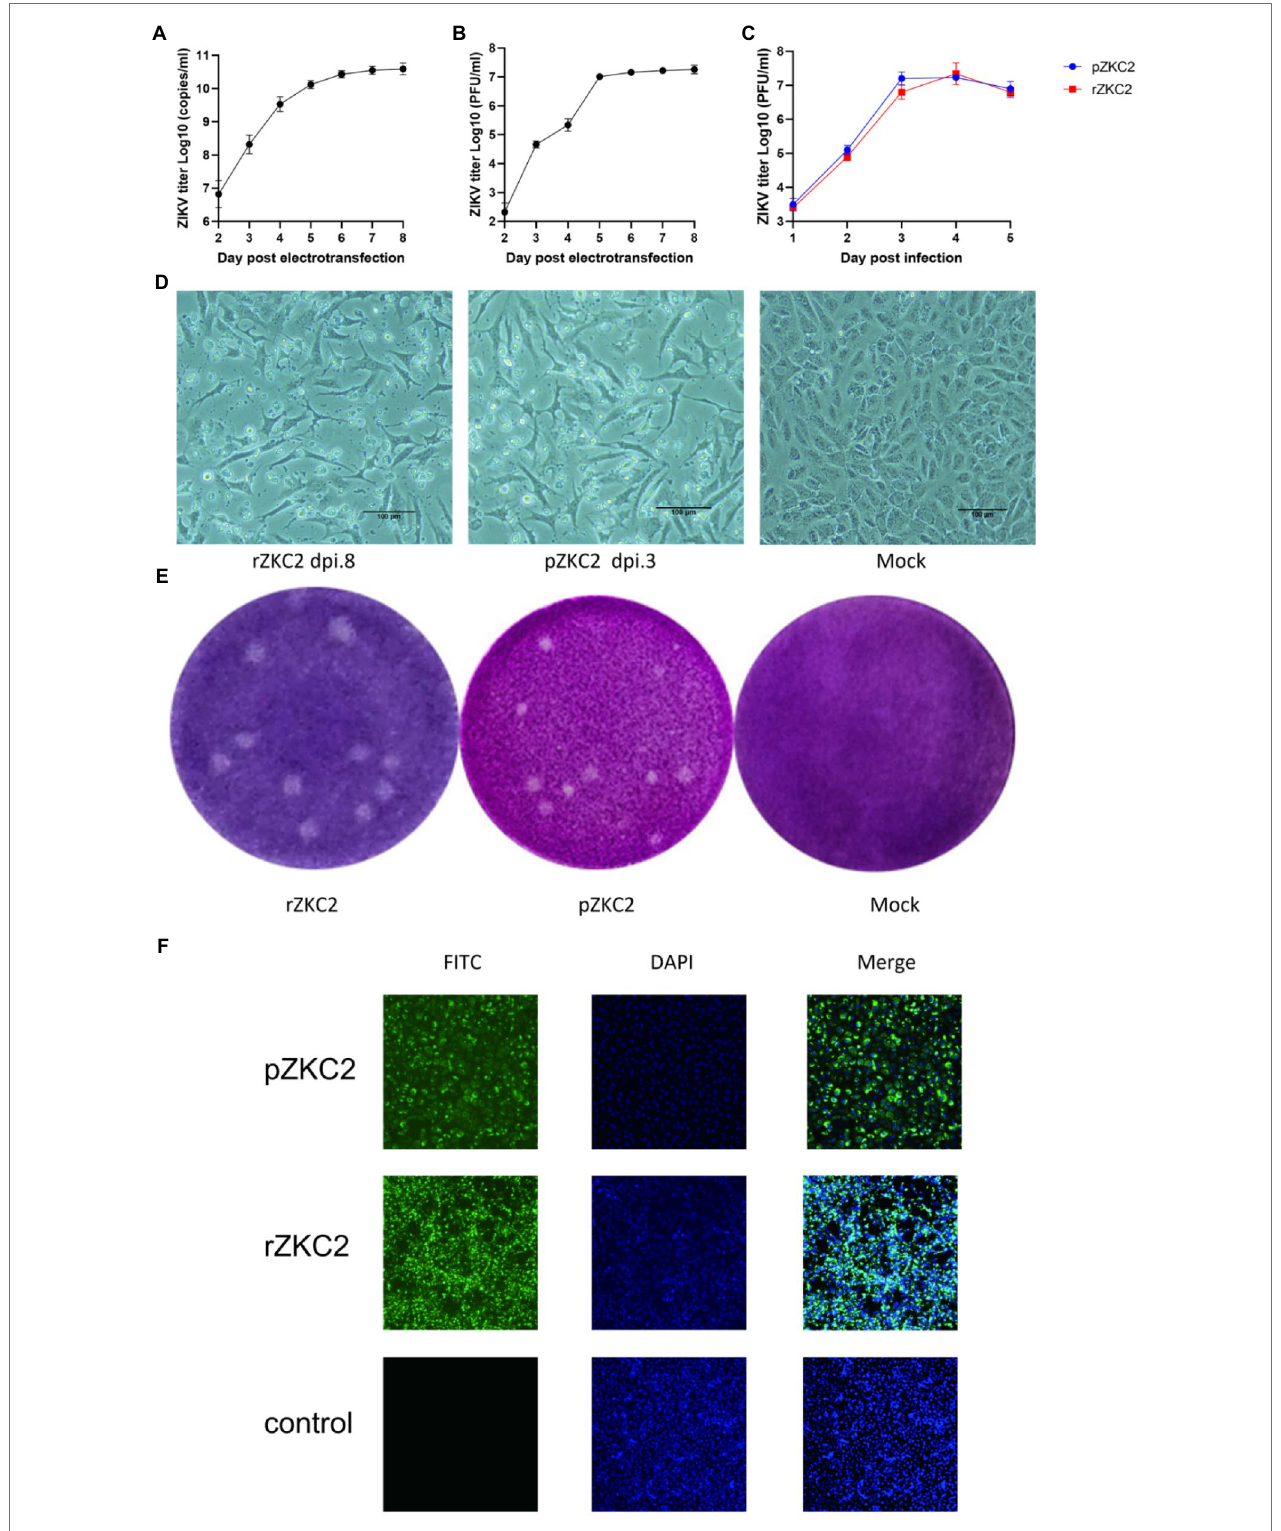
FIGURE 4 | The obtained rZKC2. (A) The viral copy number in the supernatant after eletrotransfection. (B) The infectious virus count in the supernatant after eletrotransfection. (C) Growth kinetics curves of the rZKC2 and pZKC2. (D) Cytopathic effect of the rZKC2 and pZKC2. (E) Plaque assay results of the rZKC2 and pZKC2. (F) IFA results of the rZKC2 and